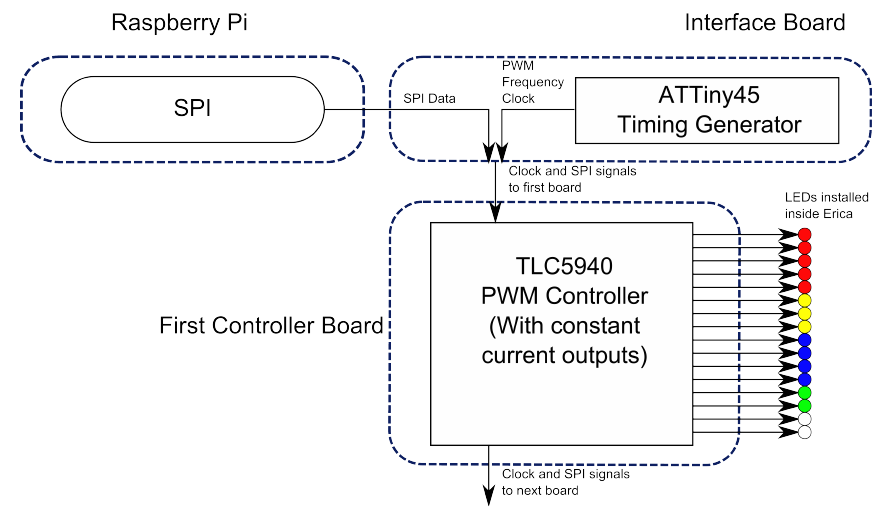
Figure 7. Original design for Erica’s LED